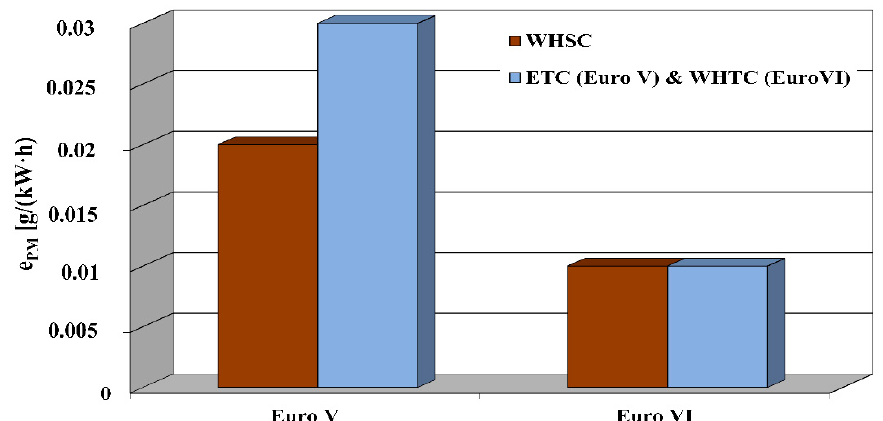
Figure 1. Limits of the specific brake emission of particulate matter using the static test WHSC (World Harmonized Stationary Cycle) for Euro V and Euro VI emission stages, and the dynamic tests ETC (European Transient Cycle) and WHTC (World Harmonized Transient Cycle) for Euro V and Euro VI, respectively (consistent with [30]).